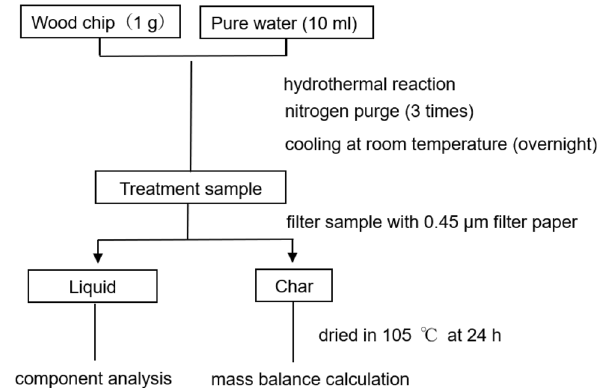
Fig. 2 Sample preparation for liquid component analysis and mass balance